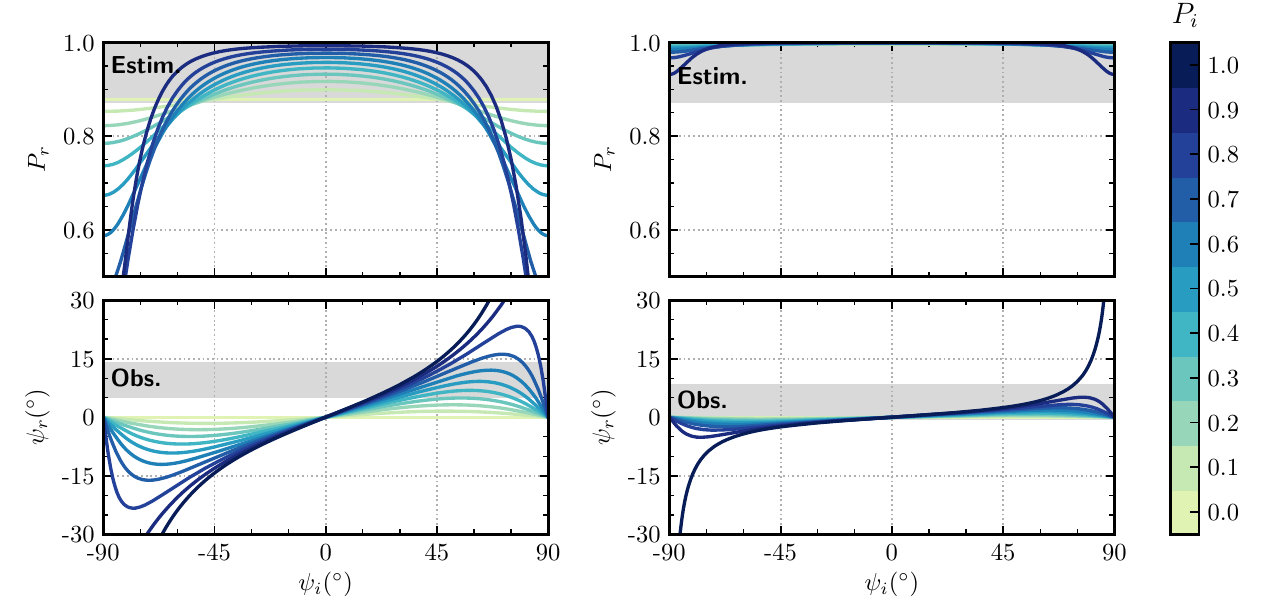
Fig. 6 Reflected polarization angle ψ r and degree of polarization P r as a function of the incident polarization angle ψ i and degree of polar- ization P i (labeled by the color). The 1 σ allowed region for the polar-